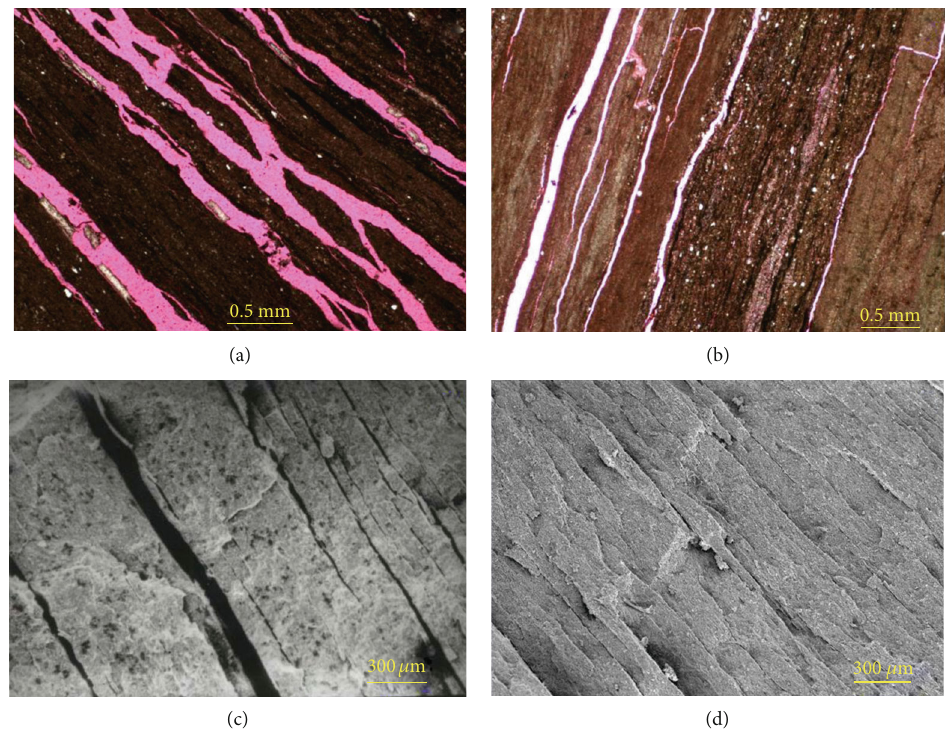
Figure 3: Distribution characteristics of lamellation fractures in the Paleogene shales in the Qianjiang Depression. (a) Casting thin section at depth of 1629.6m from WY11 well. (b) Casting thin section at depth of 1559.3m from WY11. (c) Scanning electron microscope at depth of 1491.2m from WY10-6 well. (d) Scanning electron microscope at depth of 1746.7m from WY11 well.